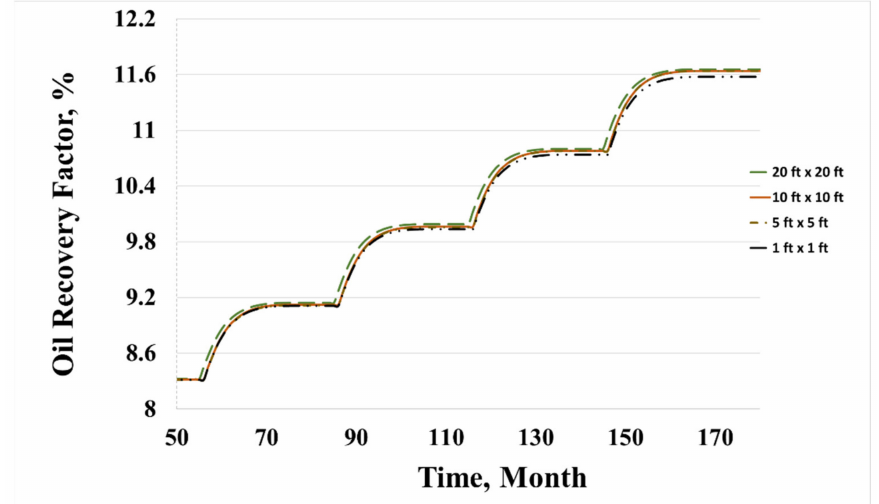
Figure 4. Grid size sensitivity analysis and its impact on the oil recovery